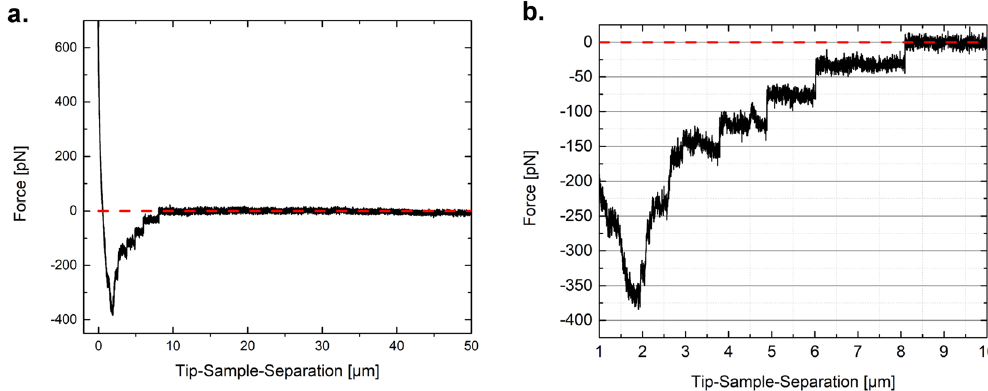
Figure 6. ( a ) A representative example of a retract curve with and adhesion peak and defined step-wise rupture events. The red line indicates the return to zero force (baseline). ( b ) Zoom-in to evaluate rupture events present in the